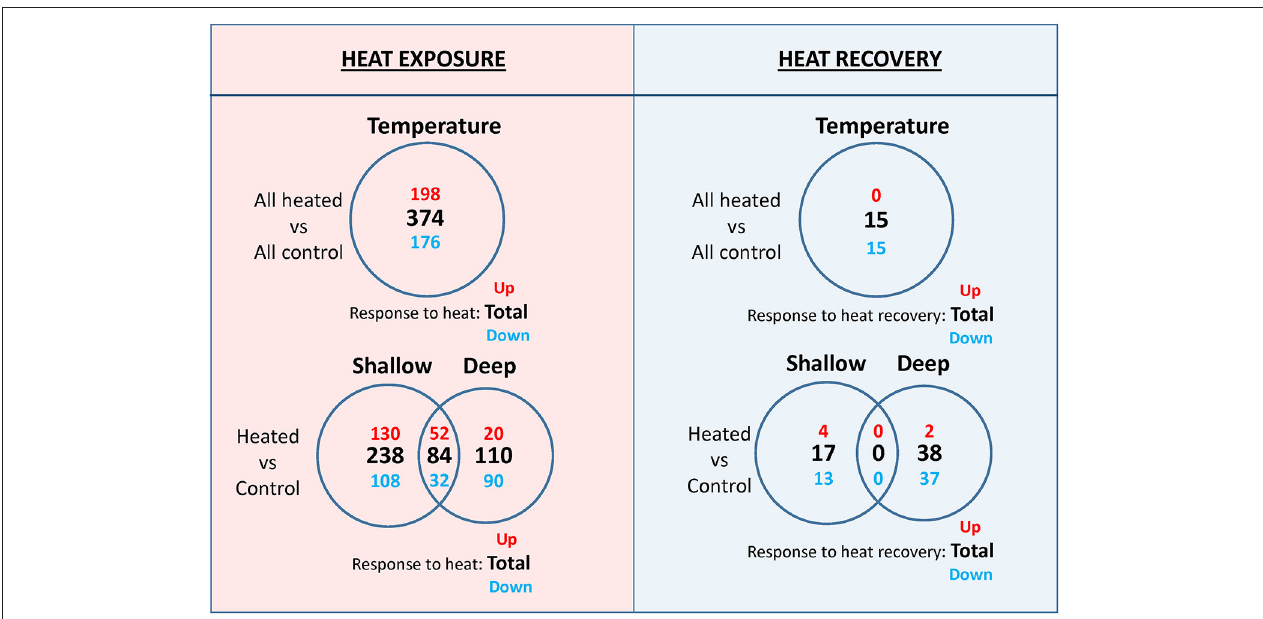
FIGURE 3 | Venn diagram showing the number of strongly differentially expressed genes (s-DEGs; > four-fold change; false discovery rate < 0.001) based on temperature, depth, within-depth heat response, and within-treatment depth differences at the end of the heat exposure (left panel) and at the end of the heat recovery (right panel) periods. Bold numbers denote totals, while red and blue numbers indicate, respectively, up-regulated and down-regulated or higher expression in shallow and in deep plants, as indicated in the